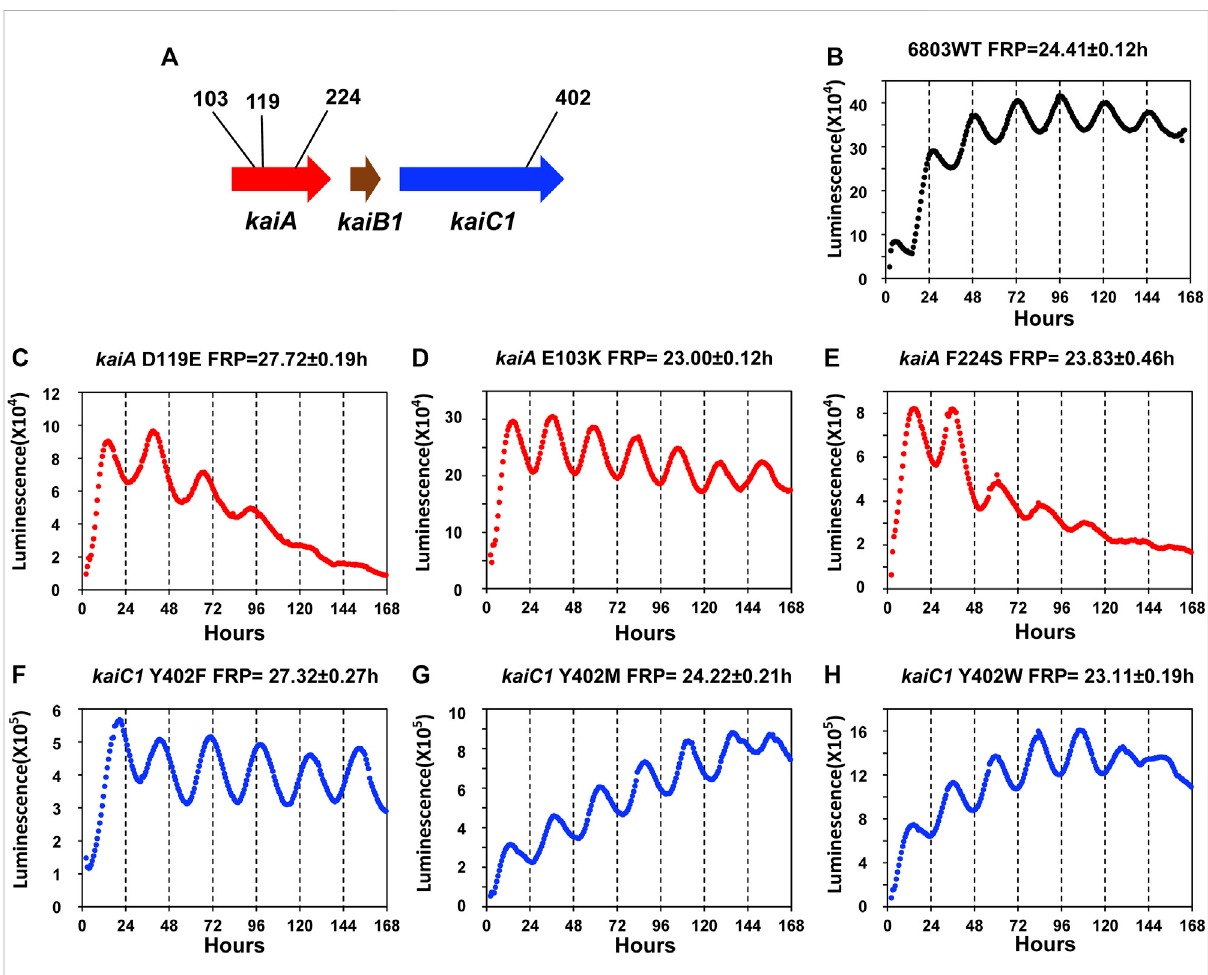
FIGURE 5 Luminescence phenotypes of period mutants in Synechocystis generated by point mutations that were informed by mutations identi fi ed in S. elongatus . (A) . Schematic diagram of the kaiA and kaiC1 loci identifying the positions of the point mutations. Panels (B – H) : rhythmicity of representative colonies of the indicated strain/mutant of Synechocystis in LL monitored by the Kondotron. (B). WT Synechocystis (FRP = 24.41 ± .12 h). (C) . kaiA D119E (FRP=27.72±.19 h). (D) . kaiA E103K (FRP=23.00±.12 h). (E) . kaiA F224S (FRP=23.83±.46 h). (F) . kaiC Y402F (FRP=27.32±.27 h). (G) . kaiC Y402M (FRP = 24.22 ± .21 h). (H) . kaiC Y402W (FRP = 23.11 ± .19 h). All FRP data are means and S.D. from three